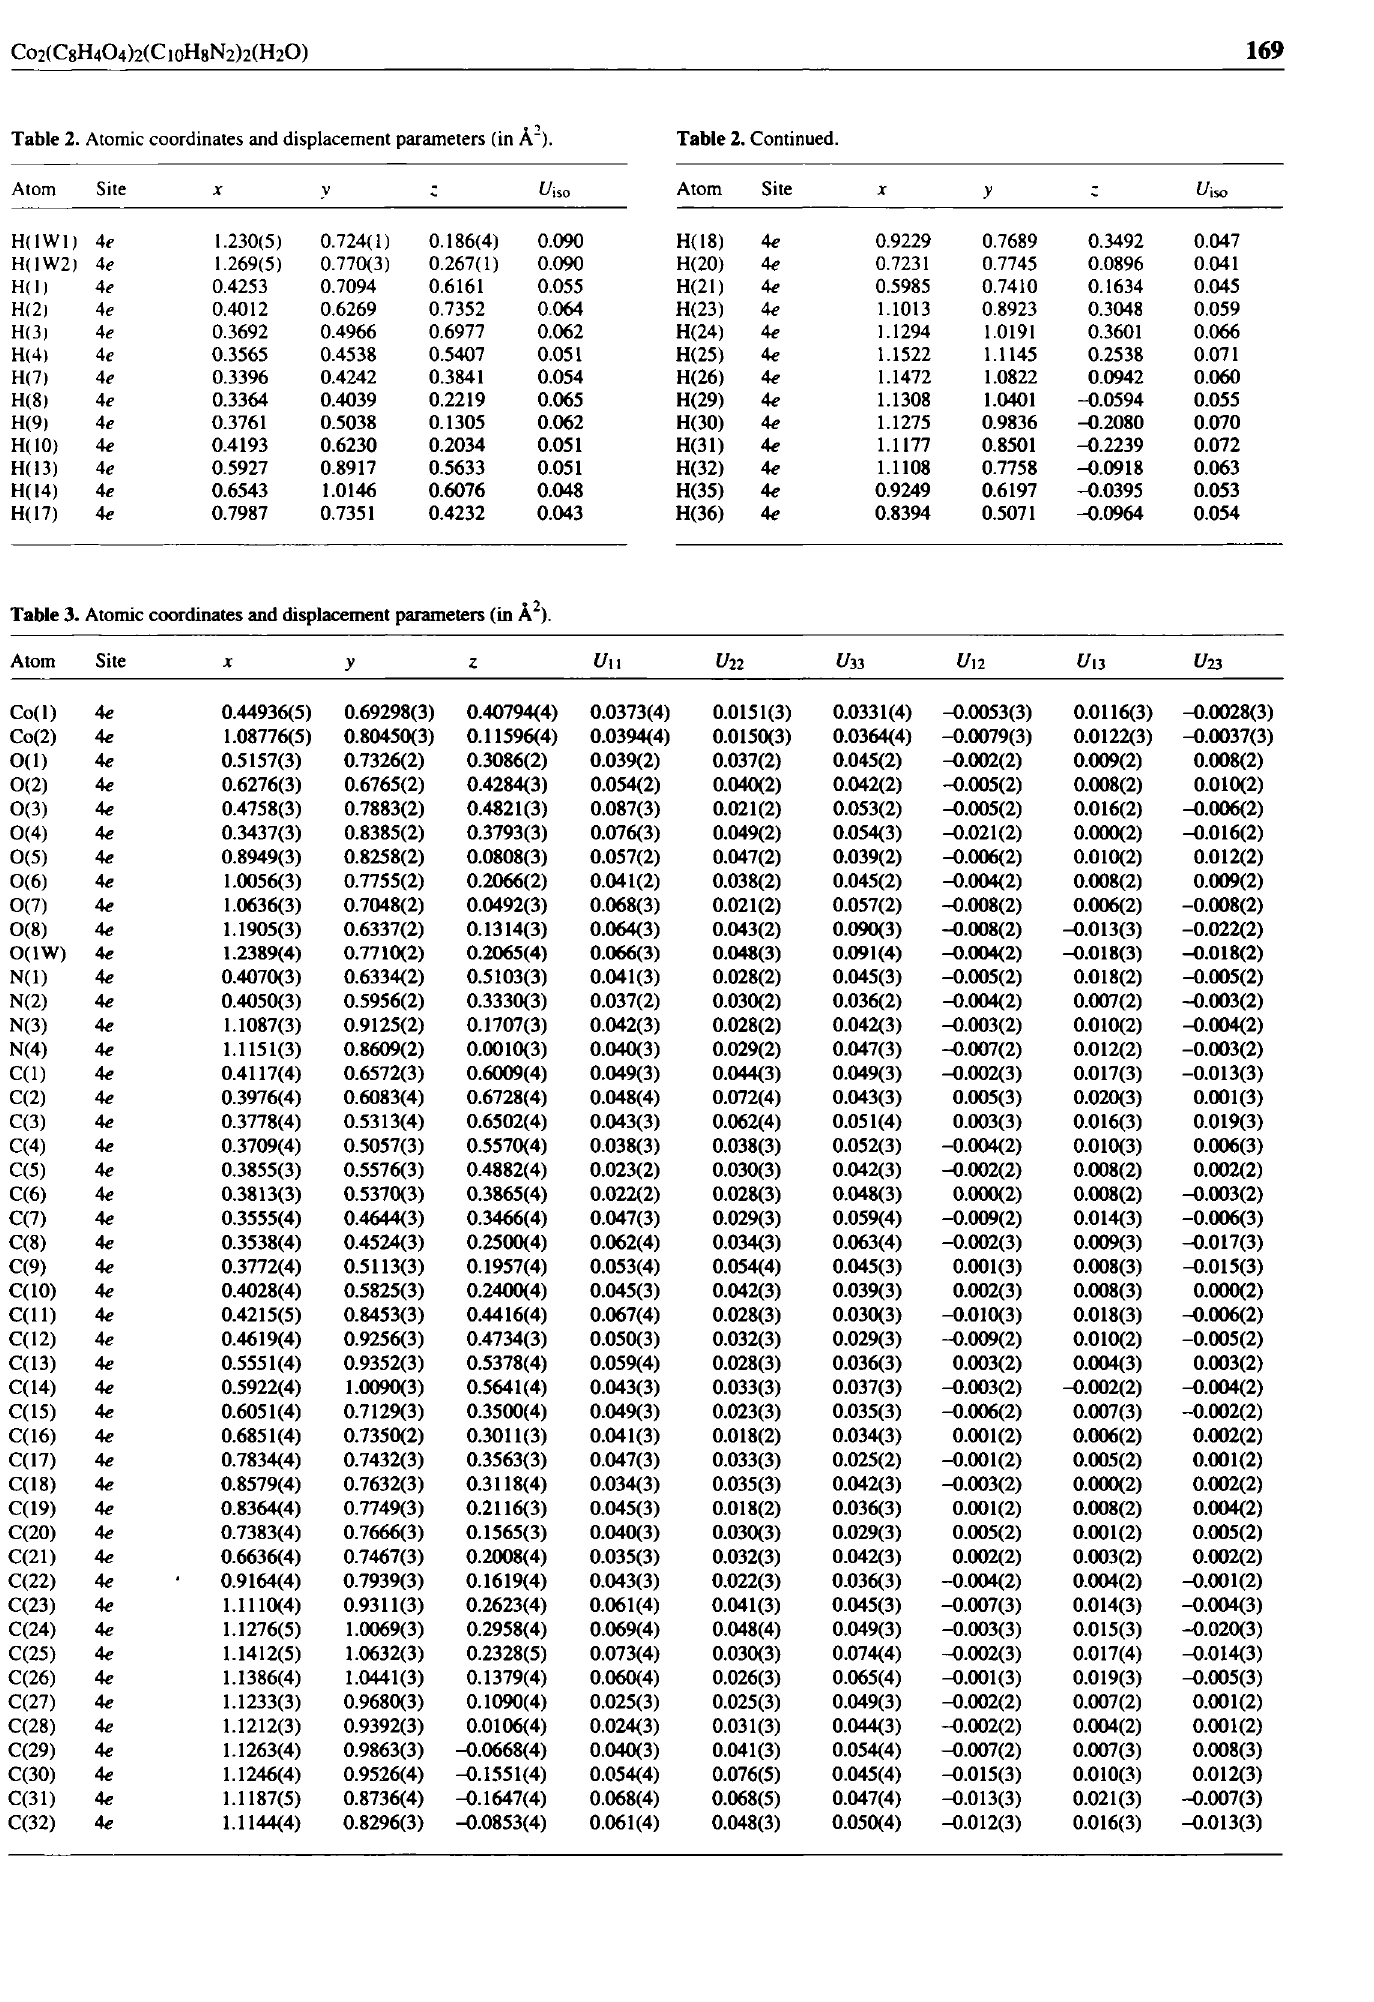
Table 2. Atomic coordinates and displacement parameters (in A 2 ). Table 2. Continued.